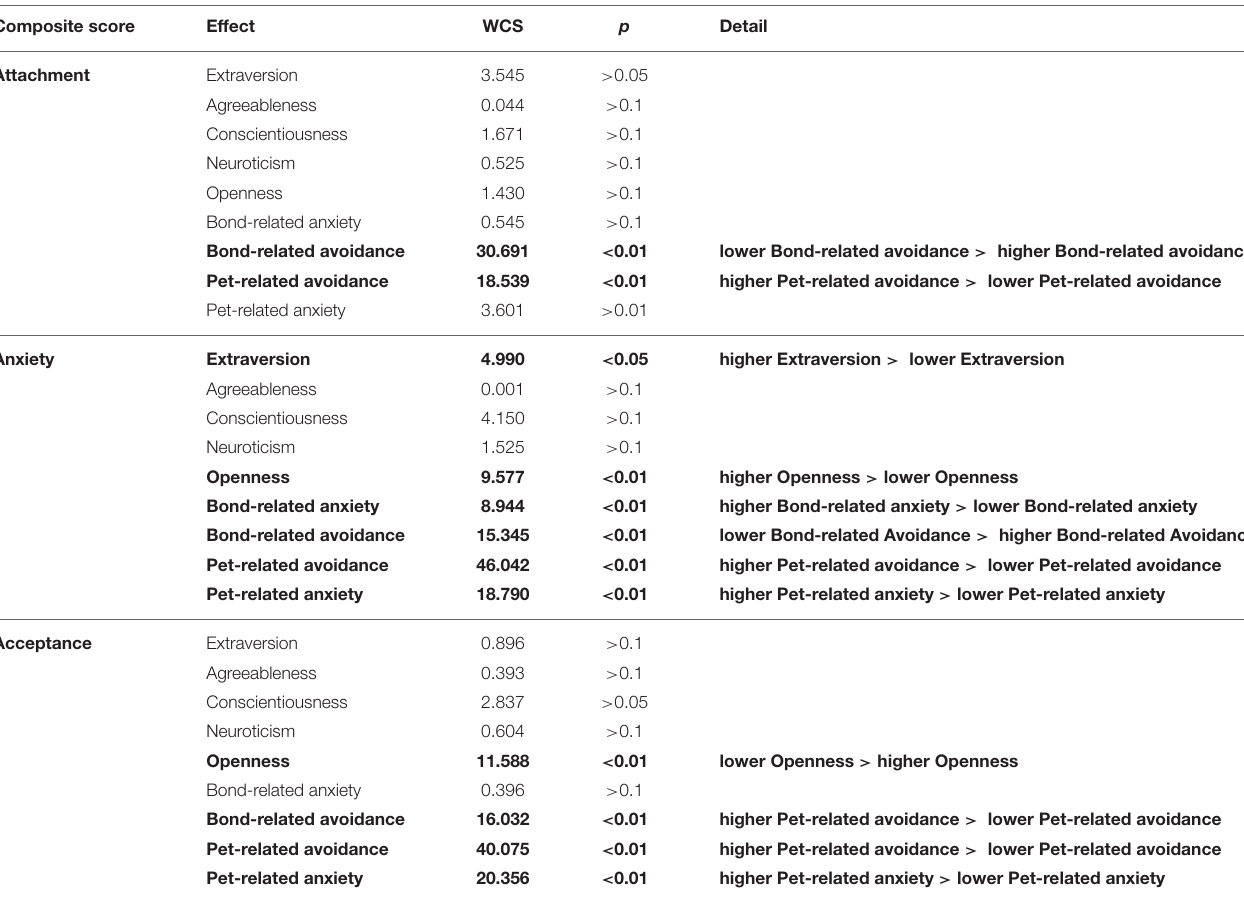
TABLE 6 | The effects of owner personality and relationship experiences with both romantic partners and dogs on dogs’ Attachment, Anxiety, and Acceptance composite scores as measured in the Strange Situation Test. Composite